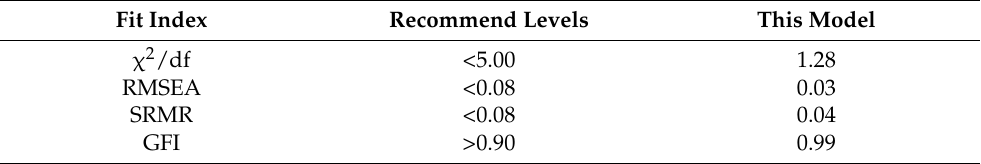
Table 4. Goodness of fit measures of the model. Fit Index Recommend Levels This Model <5.00